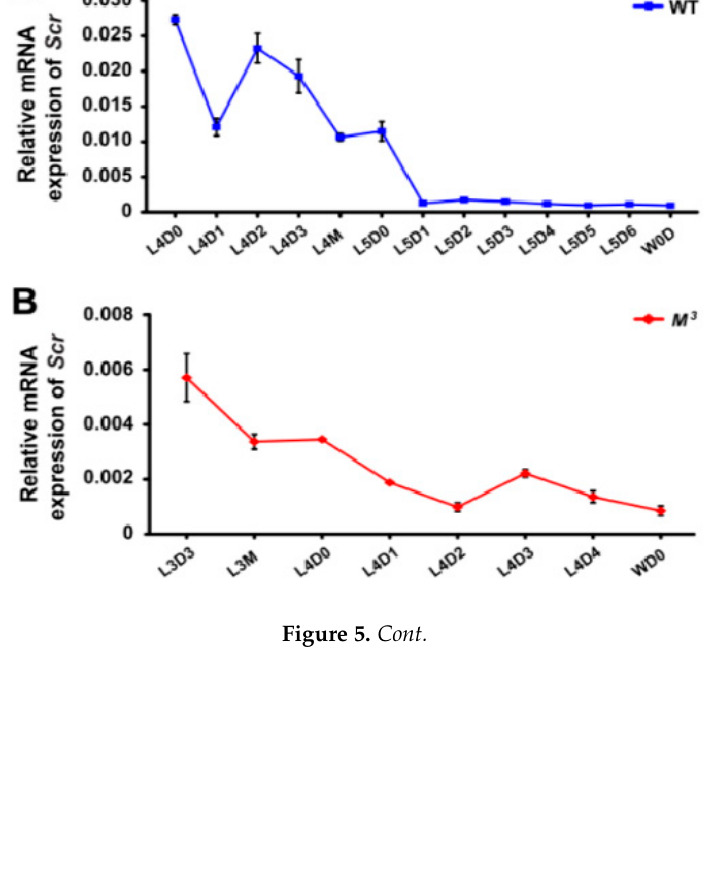
Figure 5. Cont. Figure 5. Developmental expression of the Scr gene in the M 3 and WT larvae. ( A , B ) qRT-PCR analysis of Scr expression in the Br-CC-CA complex. The results indicated that Scr was highly expressed in the Br-CC-CA complex in the early stages of either the fourth instar of WT larvae or the third instar of M 3 larvae, and that it was dramatically decreased in the final instar. This expression of the Scr gene exhibited a close correlation with the JH titer changes during the same stages; ( C ) qRT-PCR analysis of Scr expression in the areas of the head that mainly contain the Br-CC-CA complex. The results confirmed that the Scr expression levels in the head were higher in the M 3 larvae than in the WT larvae during the early feeding stage of the second instar, and these levels exhibited a positive correlation with the difference in the JH titers between the M 3 and WT larvae. L, larval instar; L2 to L5 respectively represents the second to the fifth larval instar; D, day; D0, initial day; D1 to D6 respectively represents the first to the sixth day of a larval instar; M, molting; W, wandering. The error bars represent the mean ± S.E. ( n = 3).